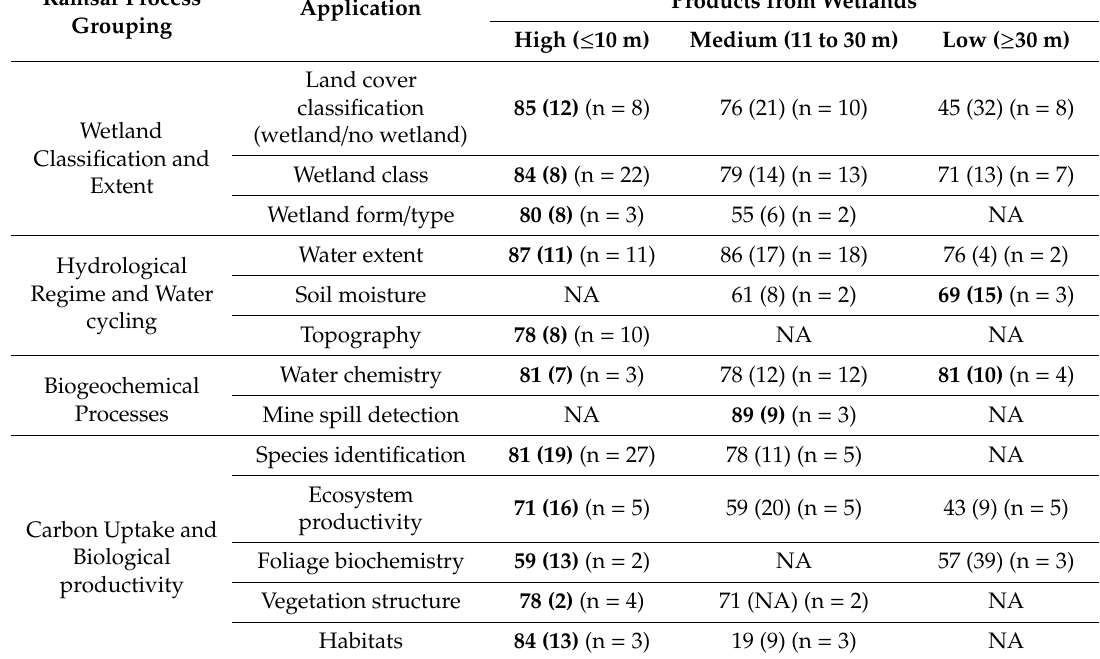
Table 2. Average and standard deviation of data product accuracy compared with measurements collected in the field and accurately located using Global Navigation Satellite System (GNSS) from combined remotely sensed data based on pixel resolution. Bold numbers illustrate pixel resolution range of highest average accuracy; n = the number of comparison results from the literature (205 examples in total); and NA represents applications where remotely sensed data products are not available for wetlands at that pixel